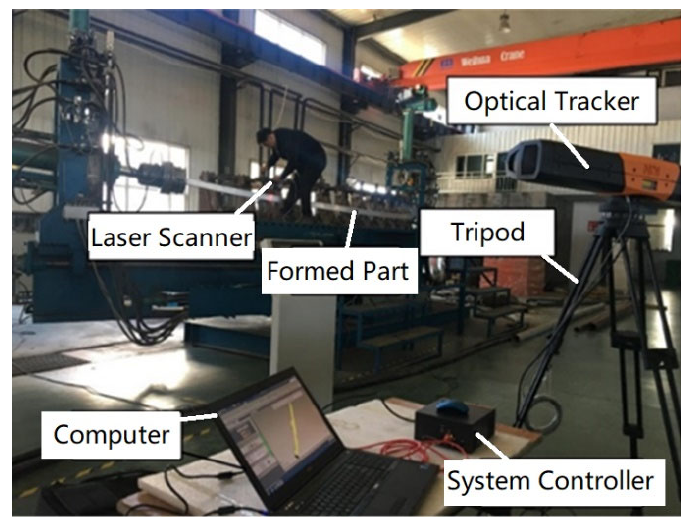
Figure 16. Optical tracking instrument.